Question: How would you classify this visualization?
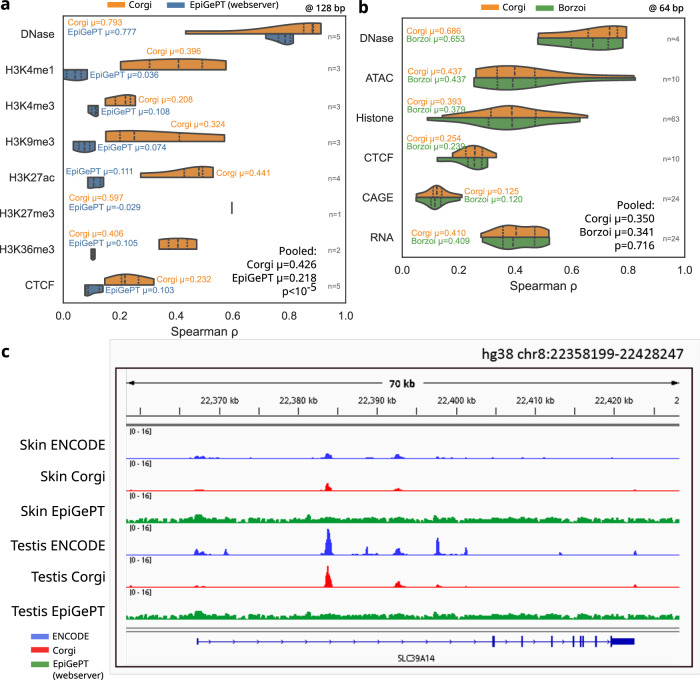
Answer: box